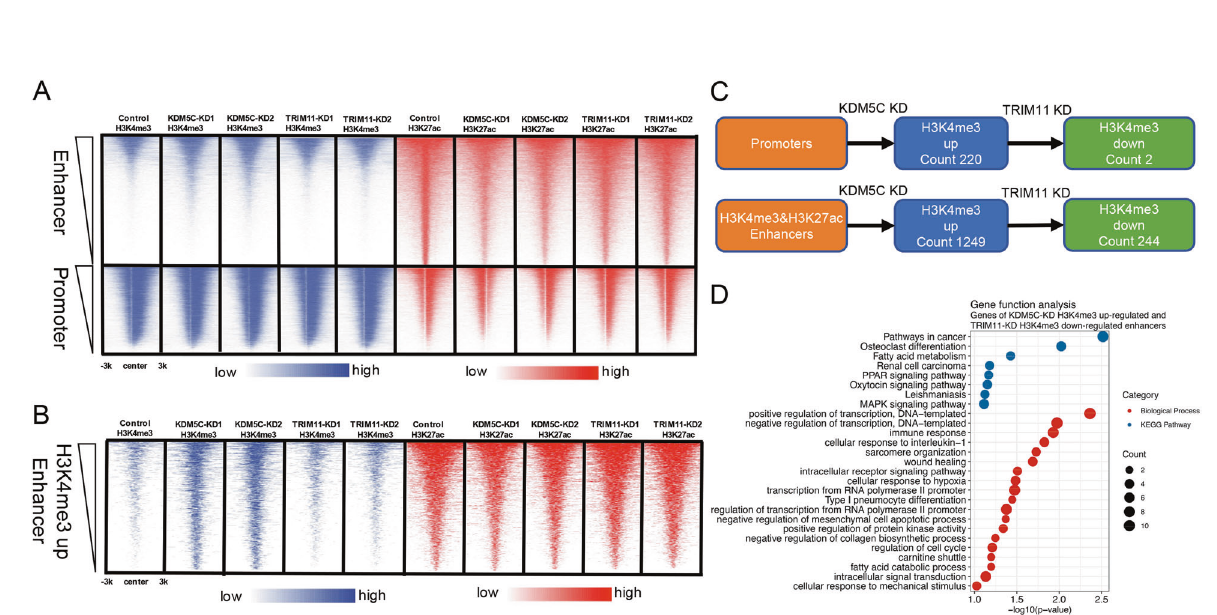
Fig. 5 TRIM11 regulates H3K4me3 on enhancers through KDM5C. A , B Heat maps generated from ChIP-seq data showing the occupancy of H3K27ac and H3K4me3 on enhancers, promoters and KDM5C regulated enhancers in TRIM11-KD and KDM5C-KD MDA-MB-231 cell lines. C A sketch map to show the pipeline to identify promoters and H3K4me3-enriched enhancers regulated by TRIM11 and KDM5C. Differential H3K4me3 peaks in KDM5C-KD were identi fi ed by 1.5-fold change, and 1-fold change in TRIM11-KD. D Biological process and KEGG pathway enrichment analyses of adjacent genes controlled by enhancers whose H3K4me3 was up-regulated in KDM5C-KD and down-regulated in tissues (Fig. 4D, E, Supplementary Fig. S5F). RNA-Seq analysis was performed and the results suggested that in comparison with the tumors of wild type mice, the different expressed genes (DEGs) in the tumors of TRIM11 de fi ciency mice were enriched in pathways of cell migration, immune response and metabolisms (Supple- mentary Fig. S5G, H, Supplementary Tables 1 – 3). All these indicated that TRIM11 plays an oncogenic role in breast cancer animal model and regulates KDM5C in breast cancer tissues. Correlation of TRIM11 and KDM5C in breast cancer patients To further explore the relationship between TRIM11 and KDM5C in breast cancer patient tissues, we performed immunohistochemical (IHC) staining with commercially available breast cancer tissue arrays (Fig. 4F). The result showed that TRIM11 mainly increased in nuclei, and KDM5C was high in the nuclei of normal tissue cells and low in the nuclei of tumor tissue cells (Fig. 4F). These suggest that in breast cancer tissues, TRIM11 probably mainly regulates KDM5C in nuclei. We divided the tissues into four subgroups according to the provided information of molecular marks, and found that TRIM11 was higher expressed and KDM5C was lower expressed in all four groups of breast cancer tissues (Fig. 4G, H). TRIM11 expression was correlated with progressive cancer stage, higher in all IIA, IIB, IIIA and IIIB stages, while KDM5C behaved the opposite (Supplementary Fig. S6A, B). TRIM11 was also expressed higher in high metastatic tumors and KDM5C was lower expressed (Supplementary Fig. S6C, D). The expression of TRIM11 and